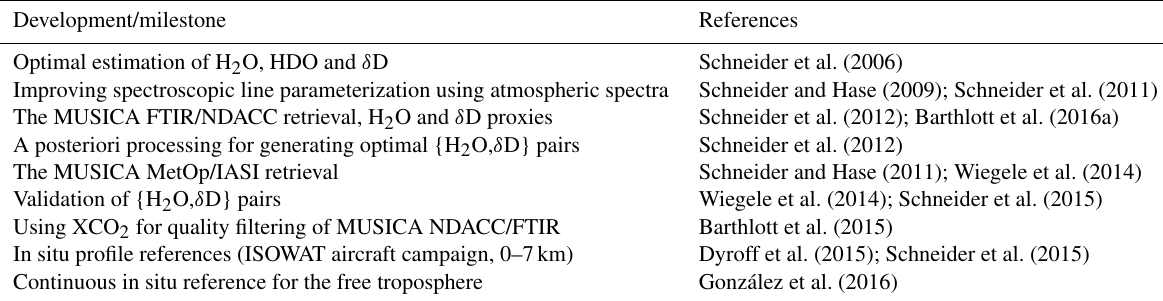
Table A1. Important developments/milestones in the context of the MUSICA